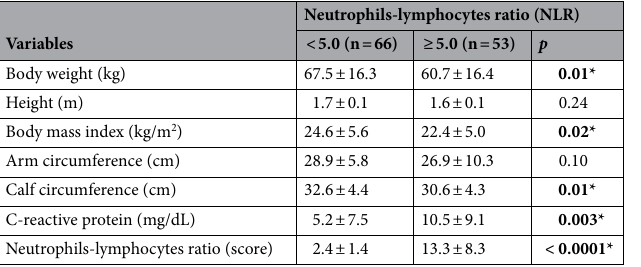
Table 2. Anthropometric and biochemical characteristics of the patients according to neutrophils- lymphocytes ratio. Data are expressed as means ± standard deviation. * p < 0.05 was considered as different.